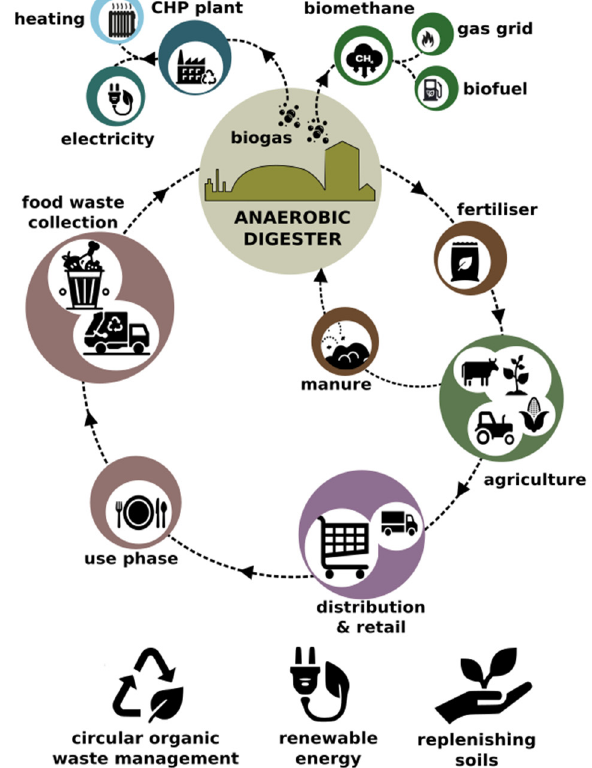
Figure 1. Anaerobic digestion: at the interface between organic waste management, renewable energy production and sustainable agriculture. Agricultural land provides food, which is distributed through the food supply chain to the consumers. The organic fraction of municipal solid waste is then treated through anaerobic digestion. The resulting biogas can be used for heating and electricity through a combined heat and power (CHP) plant or upgraded into biomethane, a substitute for natural gas. The digestate, rich in nutrients, can be used as natural fertiliser.